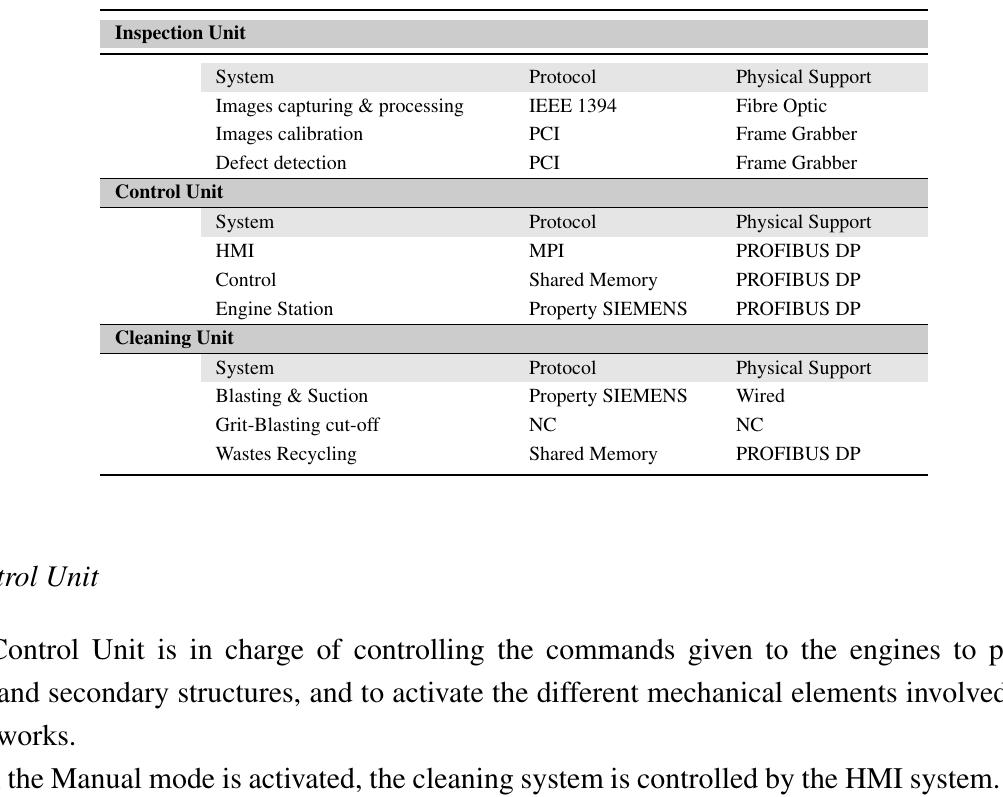
Table 2. Level 2: Communication among units and